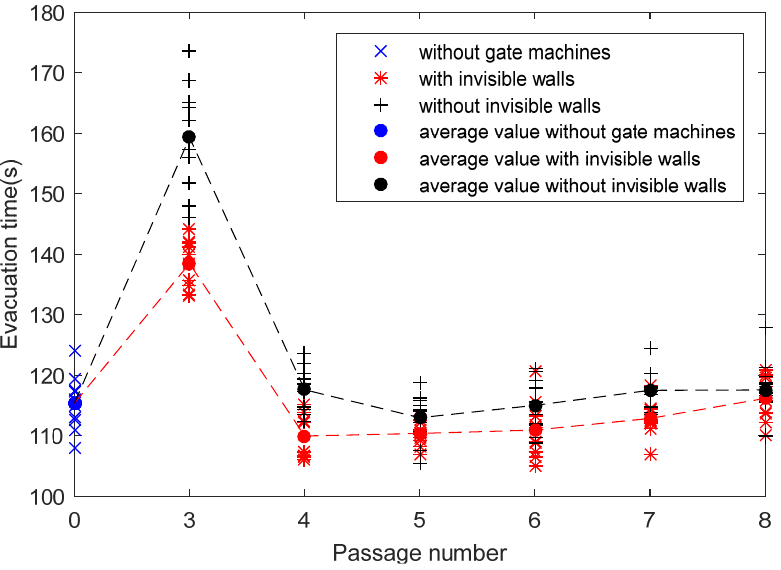
Figure 4. Change of evacuation time with the number of passages in different